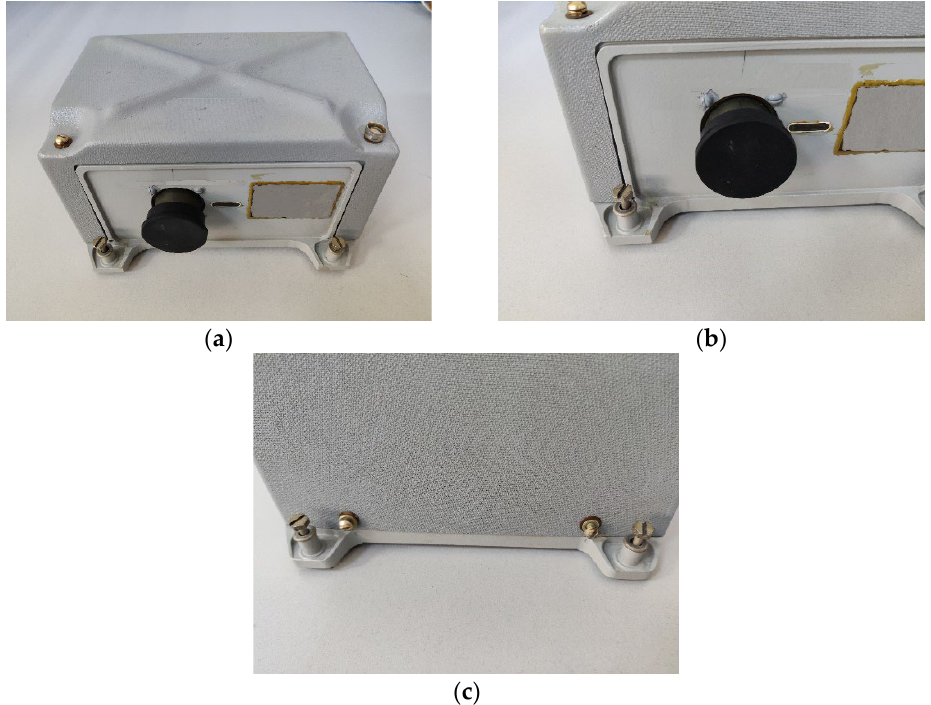
Figure 4. Electrical control box: ( a ) control box; ( b ) front panel cable interface; ( c ) the lug under the rear panel.